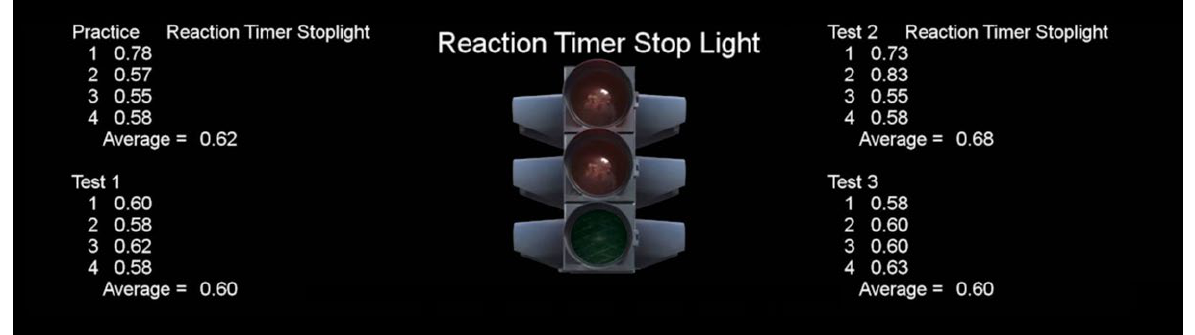
Figure 8. Results screen for Reaction Timer Stoplight©.